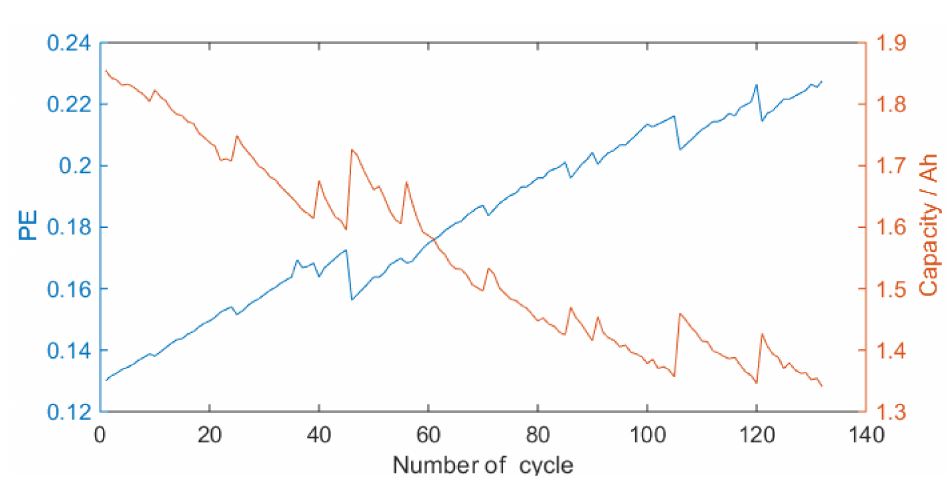
Figure 5. PE feature of battery No. 5.